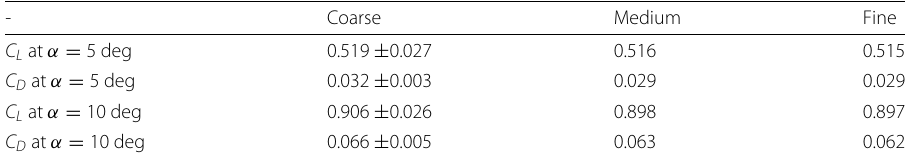
Table 3 Comparison of the lift and drag coefficients between the different spatial resolutions at α = 5 deg and α = 10 deg - Coarse Medium Fine C L at α = 5 deg 0.519 ± 0.027 0.516 0.515 C D at α = 5 deg 0.032 ± 0.003 0.029 0.029 C L at α = 10 deg 0.906 ± 0.026 0.898 0.897 C D at α = 10 deg 0.066 ± 0.005 0.063